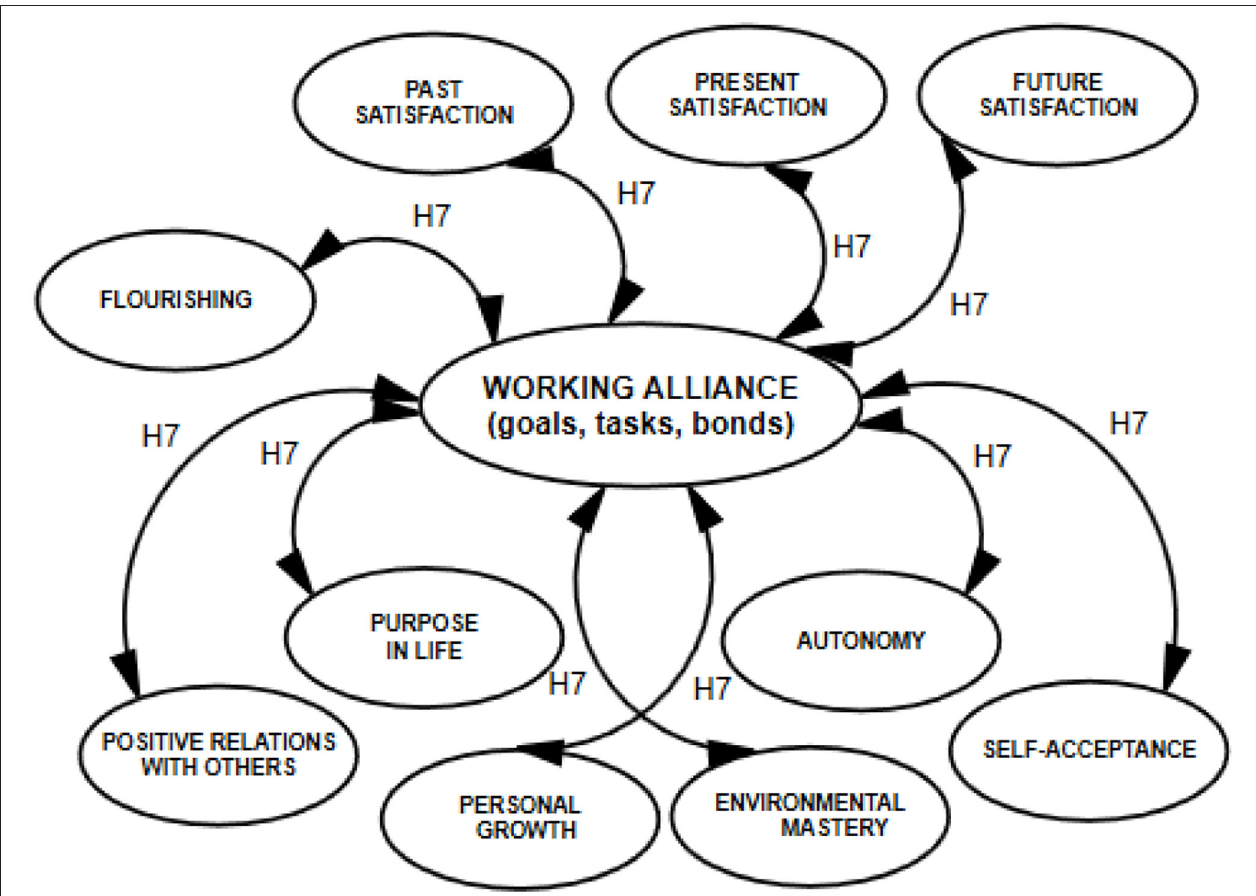
FIGURE 2 | Model of correlations detailed for the dimensions of explanatory